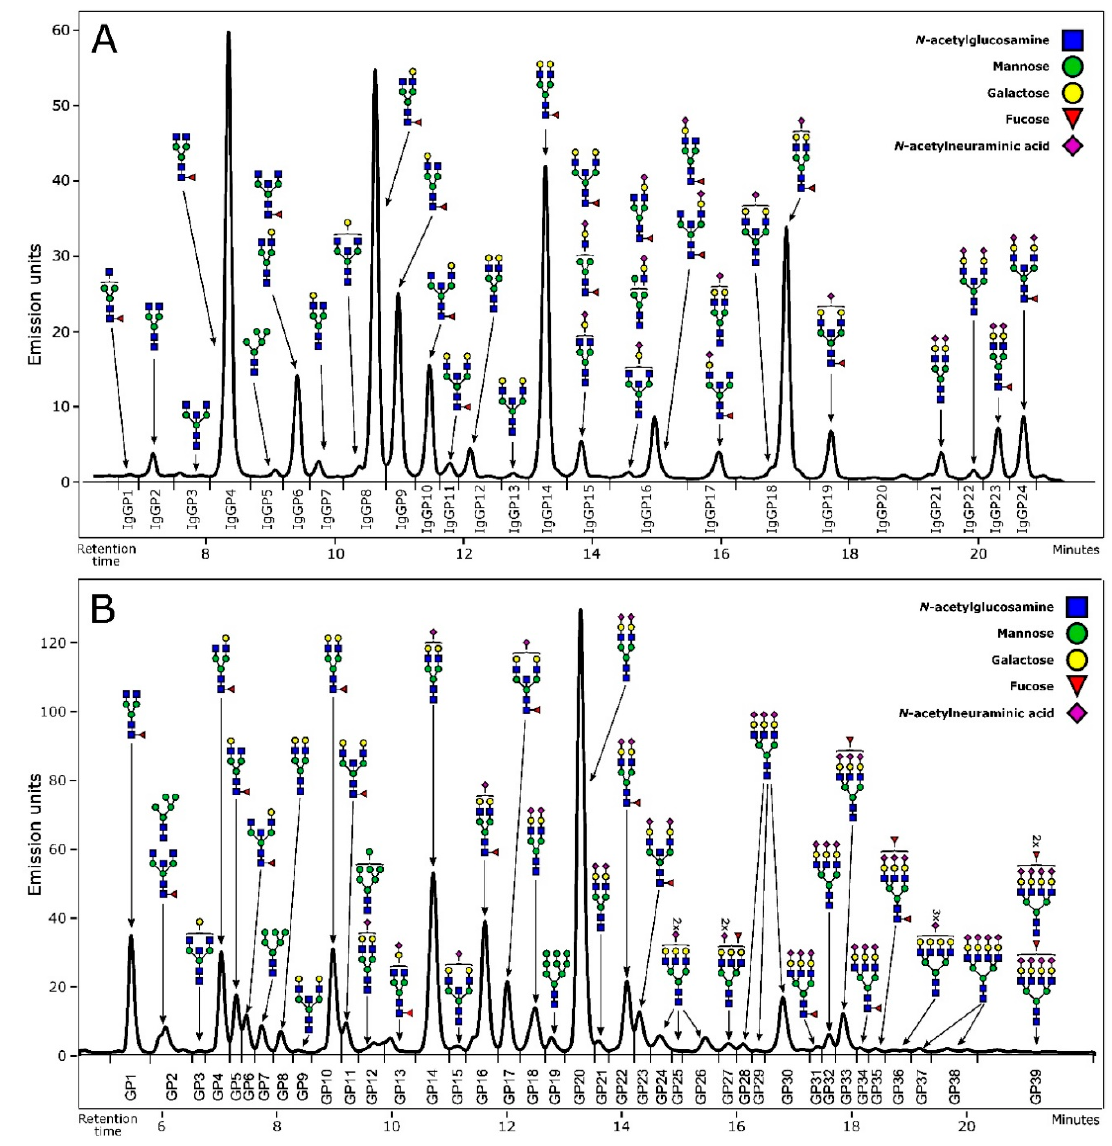
Figure 1. Representative chromatograms of HILIC-UPLC-FLR profiled N-glycans. ( a ) IgG N-glycome profile with graphical representation of the glycan structures corresponding to every IgG glycan peak (IgGP). ( b ) Plasma protein N-glycome profile with graphical representation of the most abundant structures corresponding to every plasma glycan peak (GP).